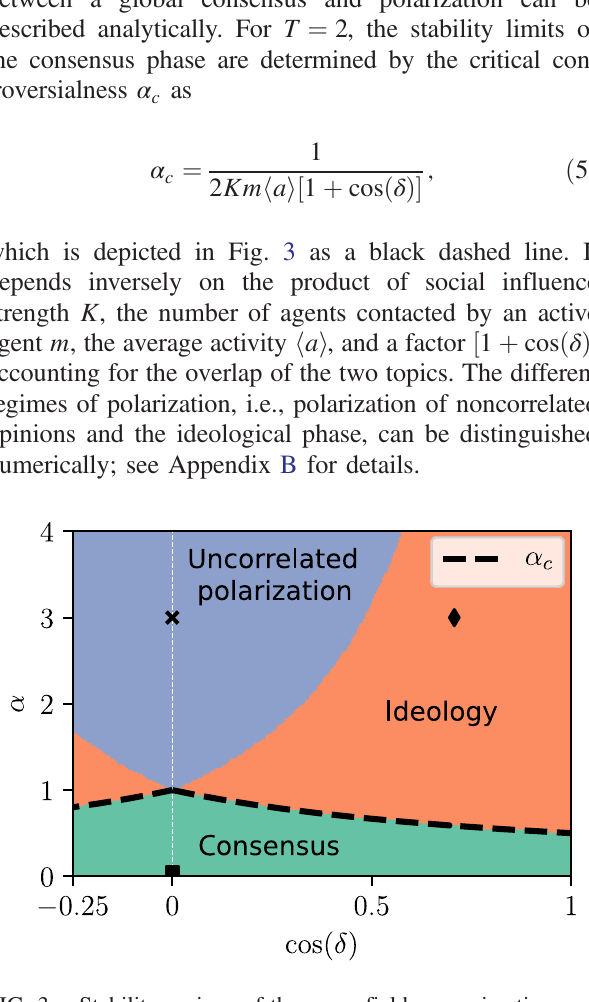
FIG. 3. Stability regions of the mean-field approximation as a function of the topic overlap cos ð δ Þ and controversialness α for 2 Km h a i ¼ 1 . The different regions in the phase space are colored according to the corresponding states: consensus (green), un- correlated opinion polarization (blue), and ideological state (orange). The black dashed line depicts the critical controversial- ness α c separating the regions of consensus and opinion polari- zation, as given by Eq. (5). The phase diagram and α c are symmetric with respect to cos ð δ Þ ¼ 0 , i.e., δ ¼ π = 2 ; see Appen- dix B for details. The symbols (square, cross, and rhombus) depict the parameter combinations of α and cos ð δ Þ used in Figs. 2 and